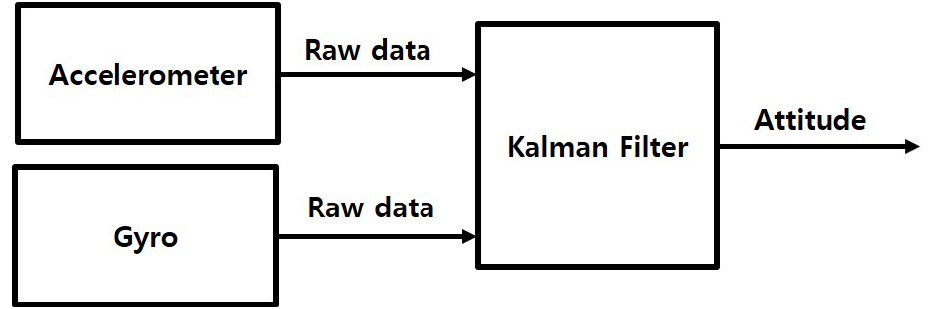
Figure 3. The block diagram of the sensor fusion for attitude